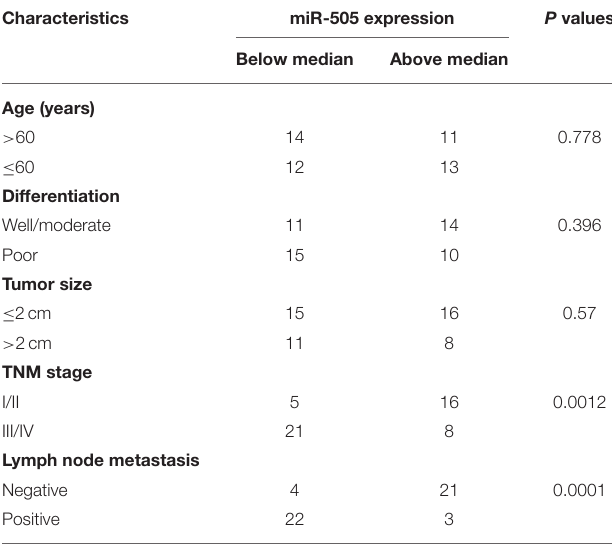
TABLE 1 | Correlation of miR-505 expression with clinical characteristics of patients with PC.